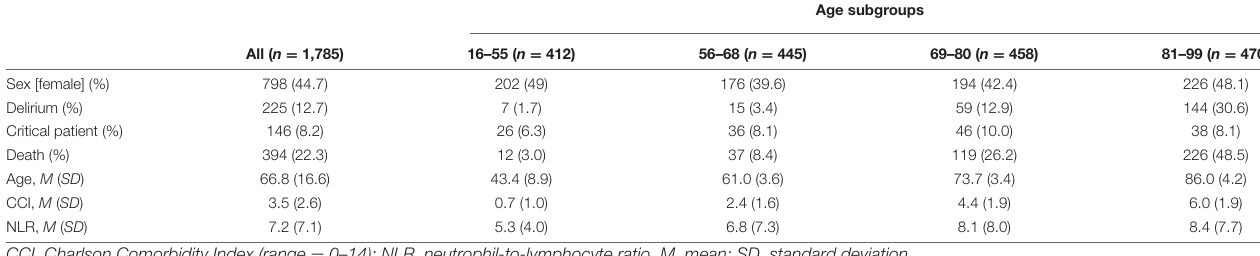
TABLE 1 | Characteristics of the participants.